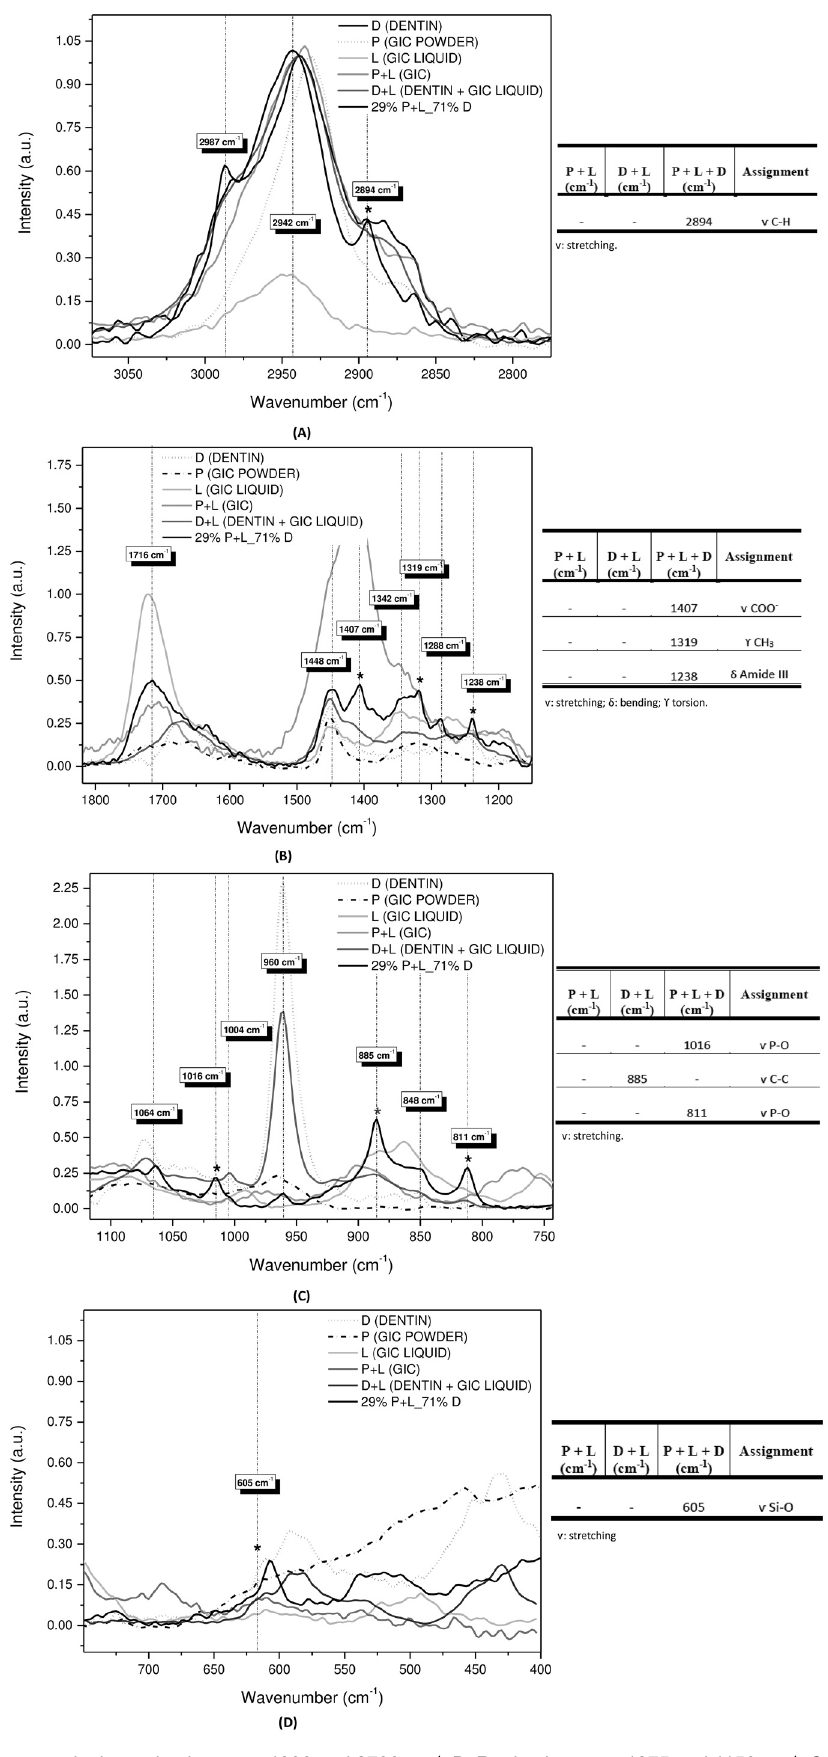
Figure 5- A: Raman spectra in the region between 4000 and 2700 cm -1 ; B: Region between 1875 and 1150 cm -1 ; C. Region between 1150 and 750 cm -1 ; D: Region between 750 and 350 cm -1 ; The tables show the Raman bands of the identified functional